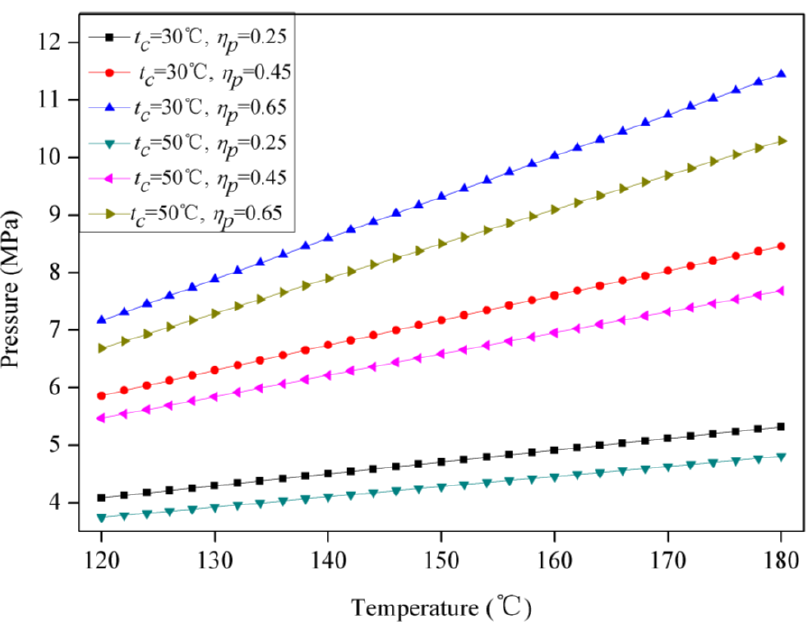
Figure 9. The p - T diagram